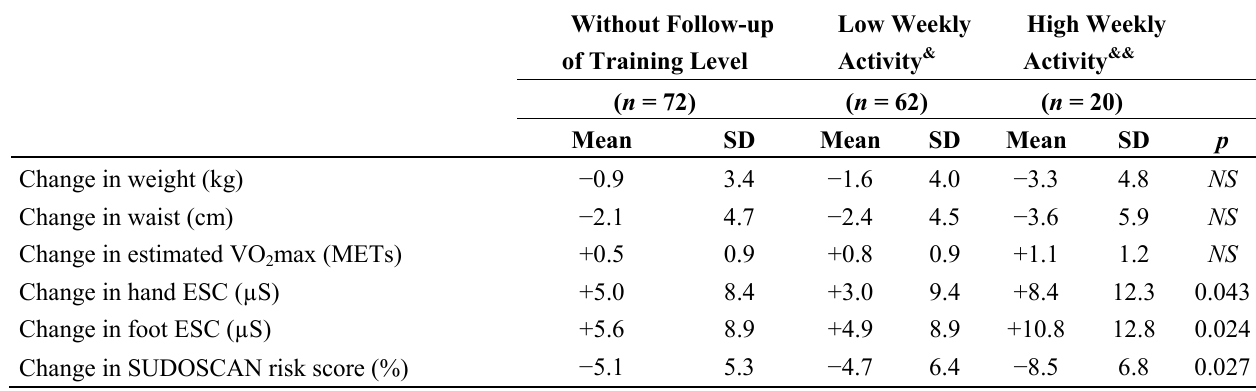
Table 3. Change between Baseline and 12-month Follow-up in Weight, Waist VO and SUDOSCAN Risk Score Value in 154 Women included in the 12-month Lifestyle Intervention Program according to Weekly Physical Activity Level assessed during 18 ± 8